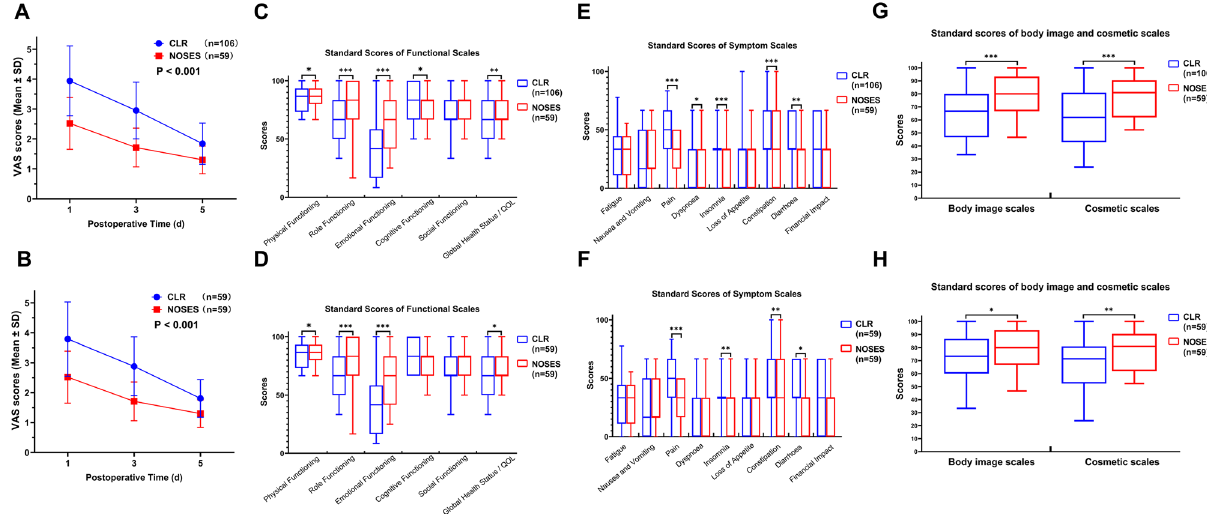
Figure 1. Comparison of short-term curative effect between two groups of patients. ( A , B ) Postoperative analgesic drug use in two groups of patients. ( A ) Before PSM. ( B ) After PSM. ( C – F ) EORCT Quality of Life questionnaire-Core 30 results of two groups. ( C ) Functional Scales (before PSM). ( D )Symptom Scales (before PSM). ( E ) Functional Scales (after PSM). ( F ) Symptom Scales (after PSM). ( G , H ) Scores of body image and cosmetic scales (Higher scores indicate better body image and higher satisfaction with scars). ( G ) Before PSM. ( H ) After PSM. (* p < 0.05, ** p < 0.01, *** p <